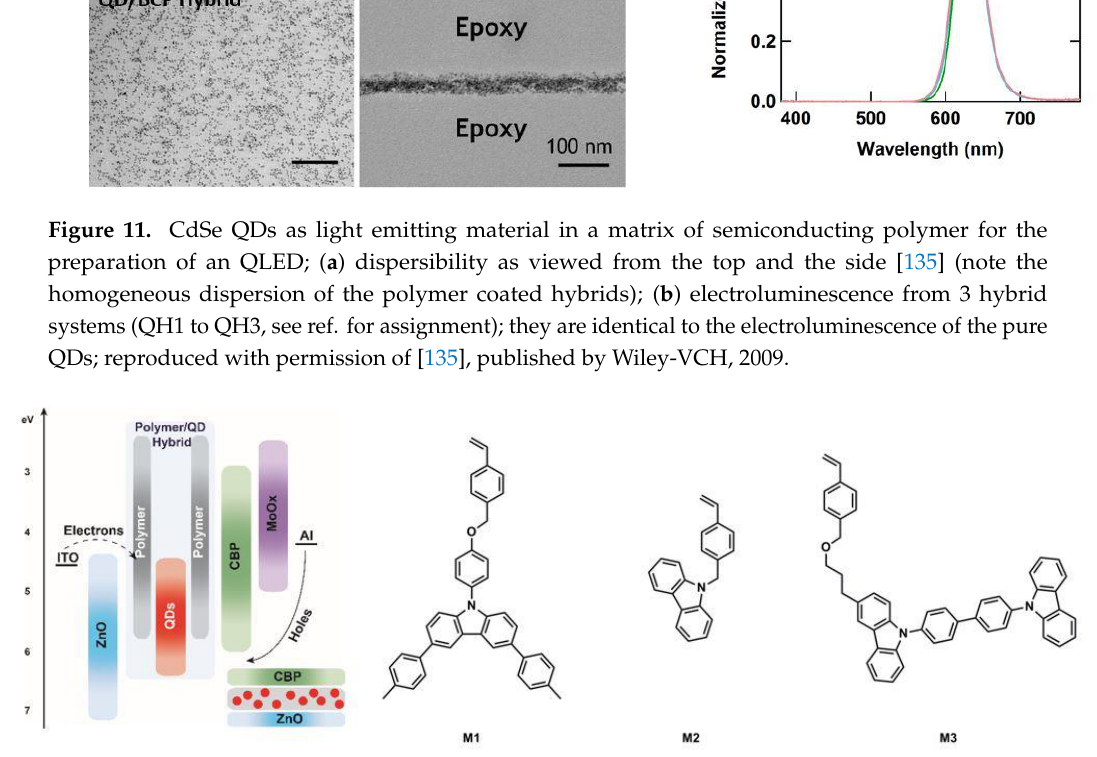
Figure 11. CdSe QDs as light emitting material in a matrix of semiconducting polymer for the preparation of an QLED; ( a ) dispersibility as viewed from the top and the side [135] (note the homogeneous dispersion of the polymer coated hybrids); ( b ) electroluminescence from 3 hybrid systems (QH1 to QH3, see ref. for assignment); they are identical to the electroluminescence of the pure QDs; reproduced with permission of [135], published by Wiley-VCH, 2009.